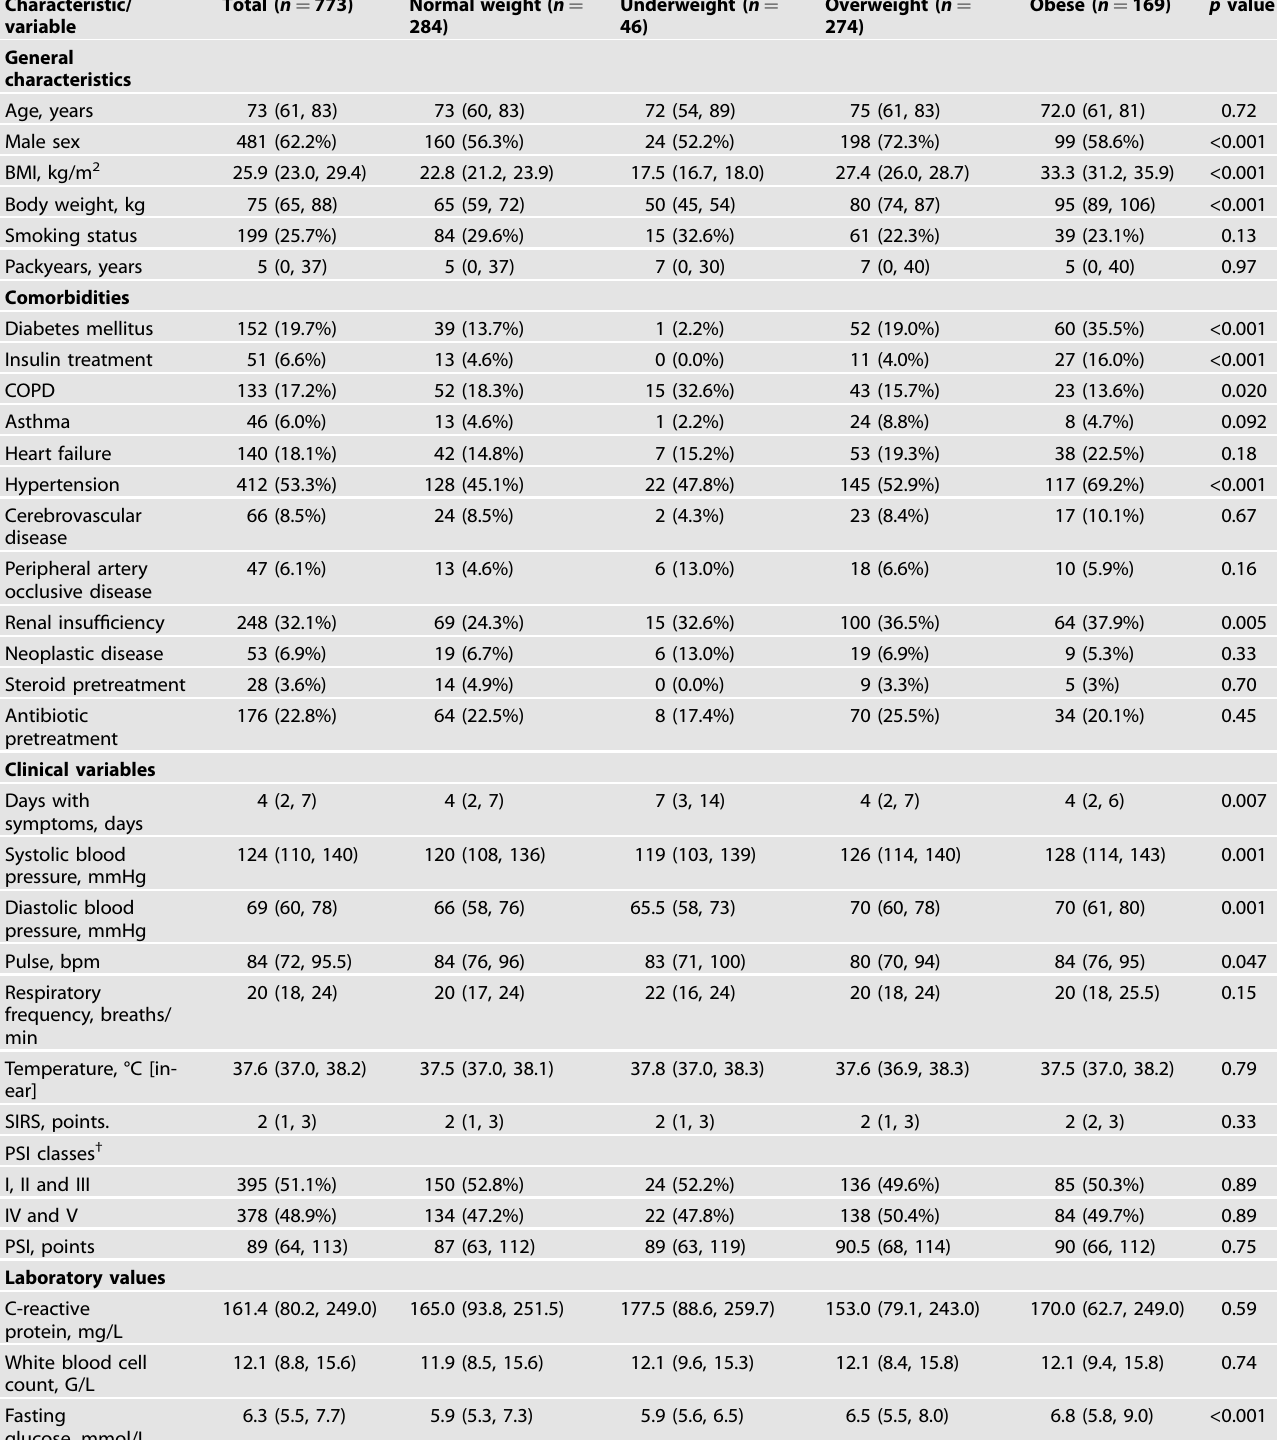
Table 1. Baseline characteristics and clinical variables of enrolled